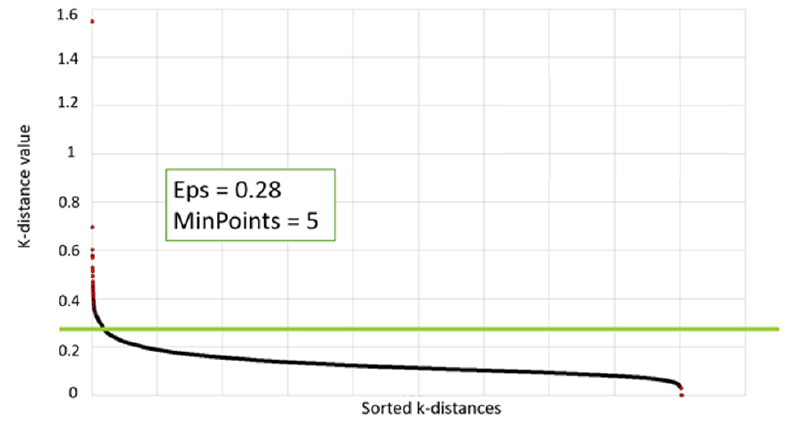
Figure 5. K-distance plot for the DBSCAN tuning